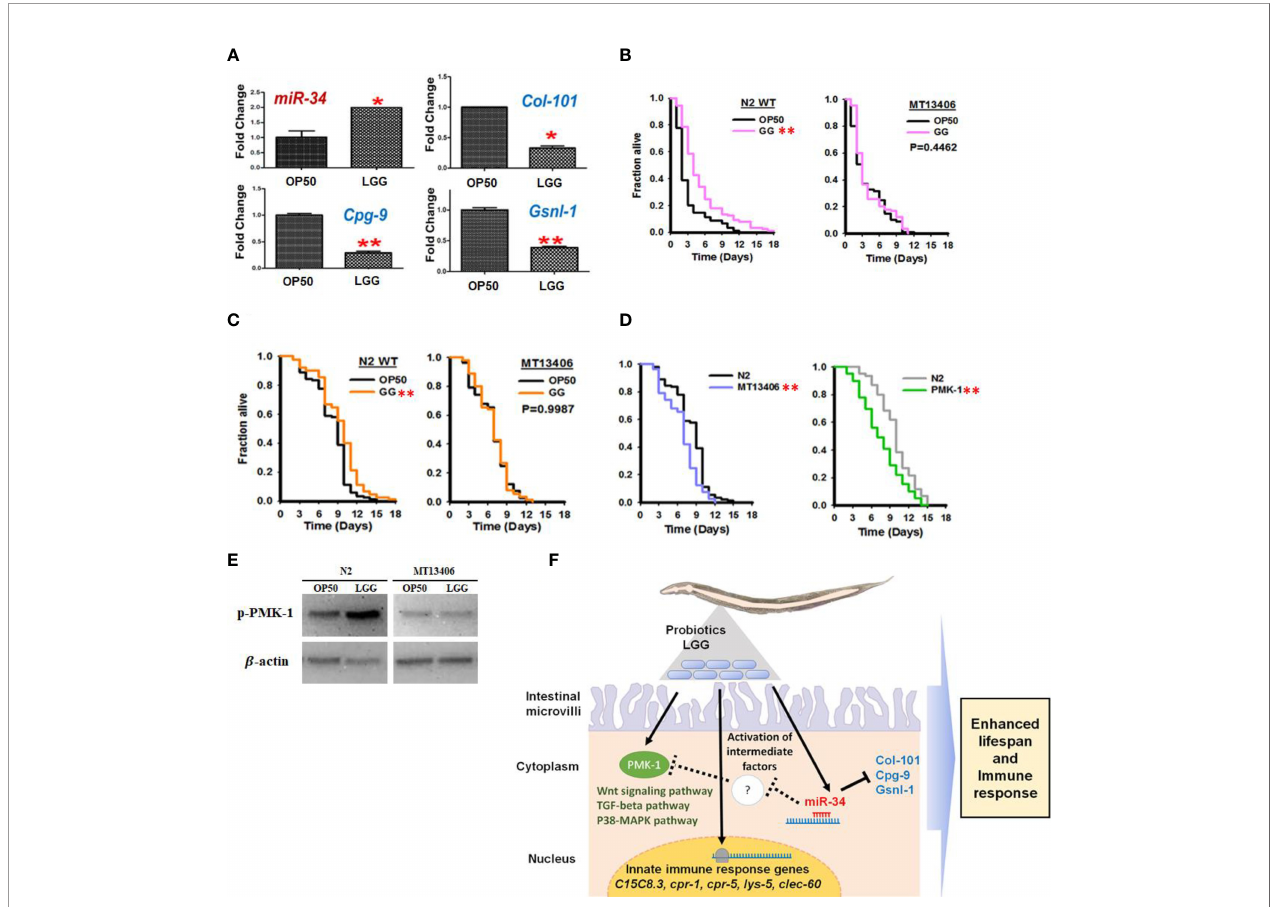
FIGURE 6 | Stimulation of miR-34 and PMK-1 pathways in C. elegans by ingestion of LGG. (A) C. elegans exposed to LGG upregulated miR-34 and inhibited its putative target genes col-101 , cpg-9 and gsnl-1 which was selected among down regulated genes from Affymetrix GeneChip_miRNA array data. (B) The killing assay of N2 wild type and miR-34 deletion mutant (MT13406) exposed to OP50 or LGG against to pathogenic bacteria ( S. aureus ). (C) The longevity assay of N2 wild type and miR-34 mutant (MT13406) exposed to OP50 or LGG (D) The longevity assay of pmk-1 deletion mutant ( km25)IV exposed to OP50 or LGG. The values are * P <0.05; ** P <0.01 compared with OP50. (E) Protein expression of phosphorylated PMK-1 in LGG or OP50 exposed to miR-34 mutant / N2 WT assessed by Western blotting. b -actin was used as loading control. (F) Potential mechanism of LGG exposure and their functions in regulating innate immunity in C. elegans through stimulating miR-34 and PMK-1. Intermediate factors including may exist between miR-34 activation and PMK-1